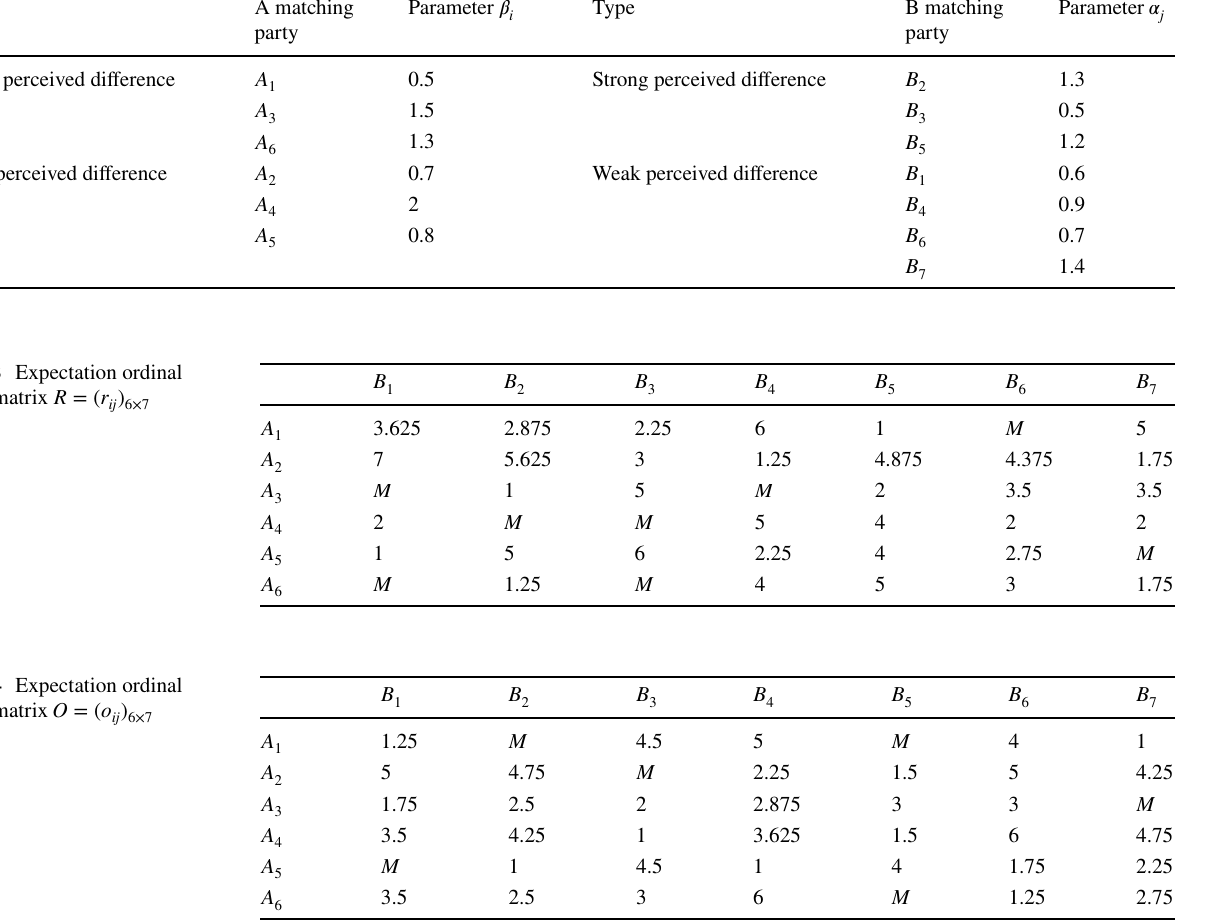
Table 2 The types and sensitive coefficient of individuals in the A matching party and B matching party Type